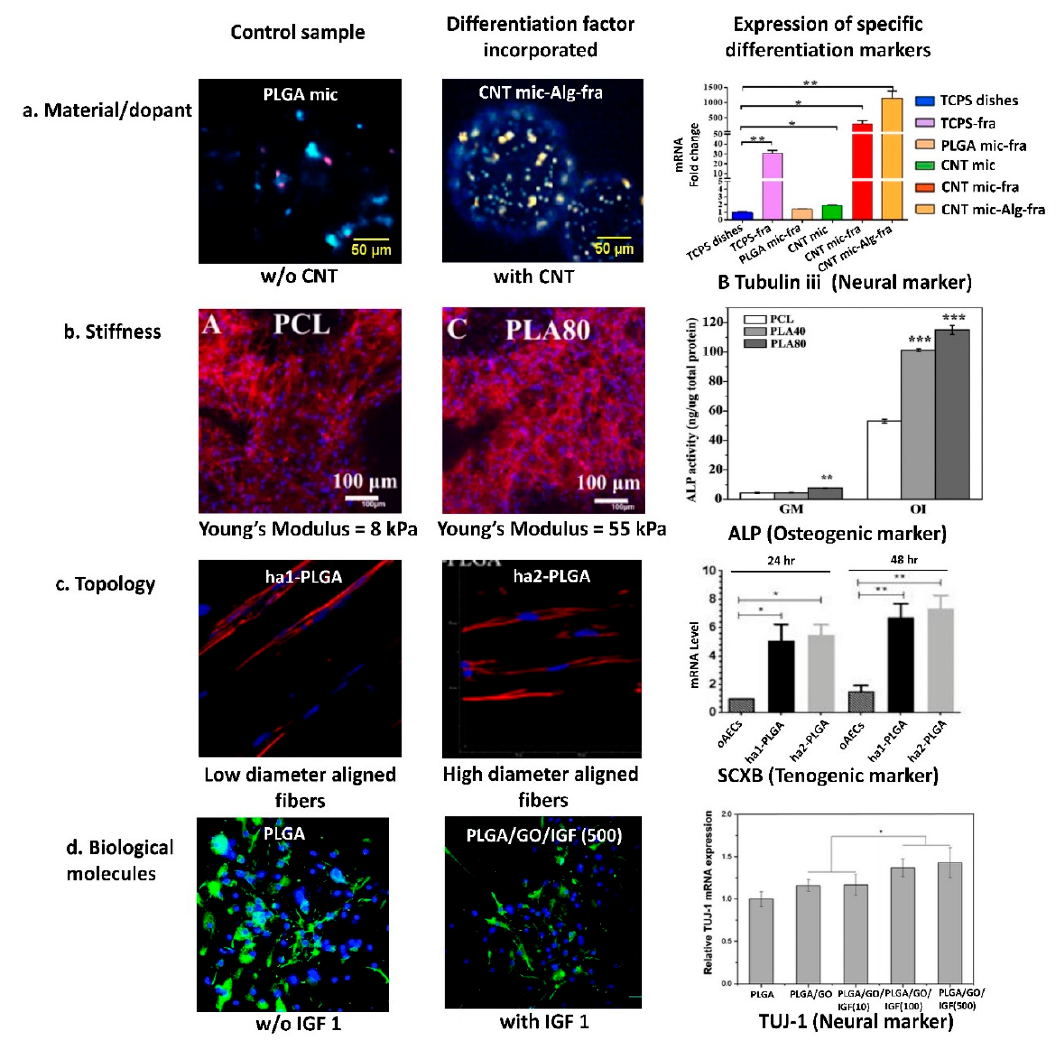
Figure 2. Factors inducing differentiation of stem cells in synthetic materials with selected examples. ( a ) Material or dopant chemistry. Alginate gel with carbon nanotube (CNT)–containing PLGA microsphere (CNT mic-Alg-fra) induced differentiation of neural stem cells (NSCs) in the presence of neural differentiation media. Left and middle column: Immunohistochemistry analysis after 8-day culture indicating the differentiation of NSCs can be improved by the presence of CNT in comparison to the control (PLGA mic: PLGA microsphere without differentiation factor). Red: B tubulin iii (neural marker); blue: DAPI staining of nuclei. Right column: Expression of β - tubulin iii measured for: control tissue culture plates without (TCPS dish) and with (TCPS-fra) differentiation media, PLGA microsphere with differentiation factors (PLGA mic-fra), PLGA-CNT microsphere without (CNT mic) and with (CNT mic-fra) differentiation media and, PLGA-CNT microsphere enclosed in alginate gel with differentiation factor (CNT mic-Alg-fra). CNT mic-Alg-fra revealed significantly higher expression of the differentiation marker. Adapted with permission from [130]. ( b ) Scaffold stiffness. 3D electrospun meshes with increased stiffness-induced osteogenic differentiation of human mesenchymal stem cells (hMSCs) in osteoinductive media. Left and middle column: Immunohistochemistry analysis of 16 h culture indicating that PLA 80 (20% PCL–80% PLA) electrospun meshes with relatively higher stiffness improved hMSCs differentiation in comparison to less stiff pure PCL meshes (PCL). Red: Texas Red-Phalloidin staining of F-actin; blue: DAPI staining of nuclei. Right column: Higher activity of alkaline phosphate was detected in stiffer samples (PLA 80) in comparison to less stiff samples PLA 40 (60% PCL–40% PLA) and control (PCL). Adapted with permission from [117]. ( c ) Scaffold topology. Electrospun PLGA nanofiber meshes composed